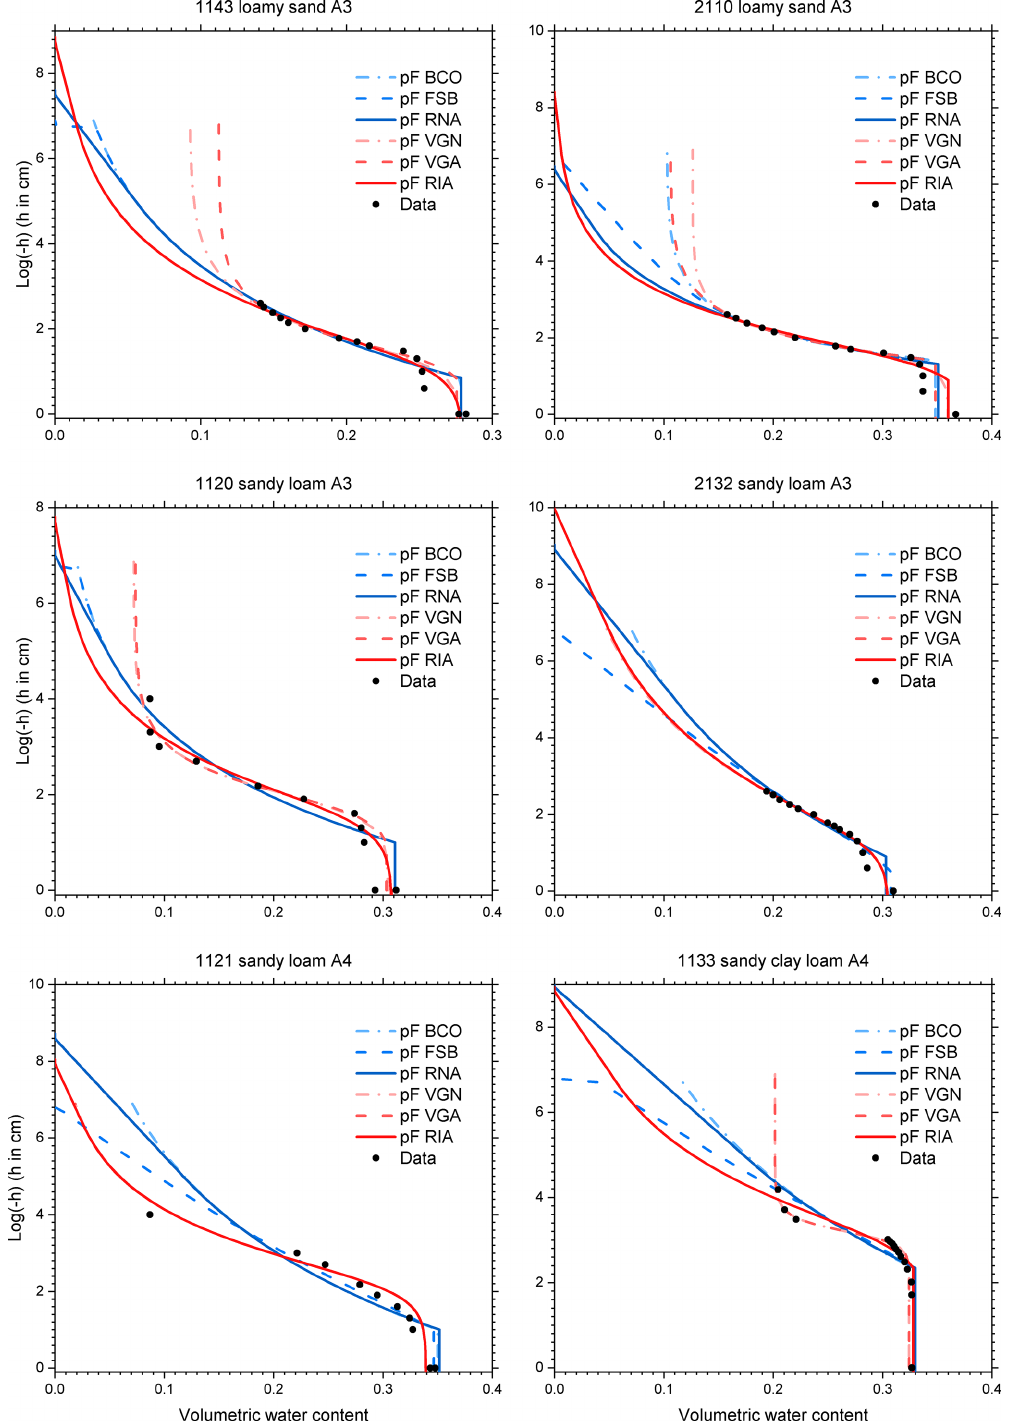
Figure C3. Retention data and fitted soil water retention curves according to six parameterizations for selected UNSODA soils with the A3 or A4 classification of Twarakavi et al. (2010). The parameterizations are explained in the text.